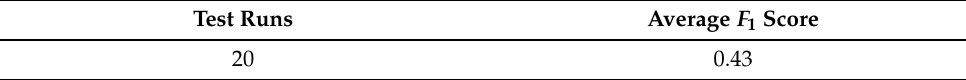
Table 2. Zeus/ISFB SVM Model